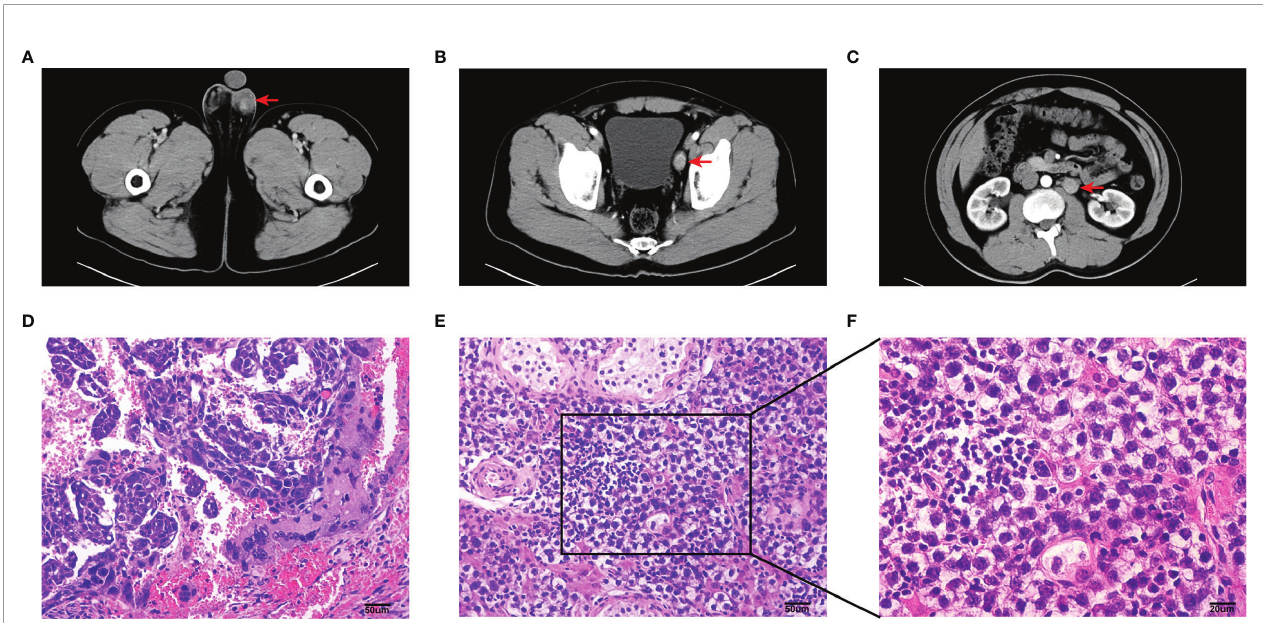
FIGURE 1 | Imaging and pathological information of this sample. (A – C) Computed tomography (CT) plain and arterial images of primary testicular tumor (A) , pelvic lymph node (B) and renal hilus lymph node (C) metastases. Tumor and lymph node metastases (red arrow). (D – F) Photomicrographs of HE stained sections in the sample of testicular tumor. Scale bar, 50 um (D, E) . Scale bar, 20 um (F)